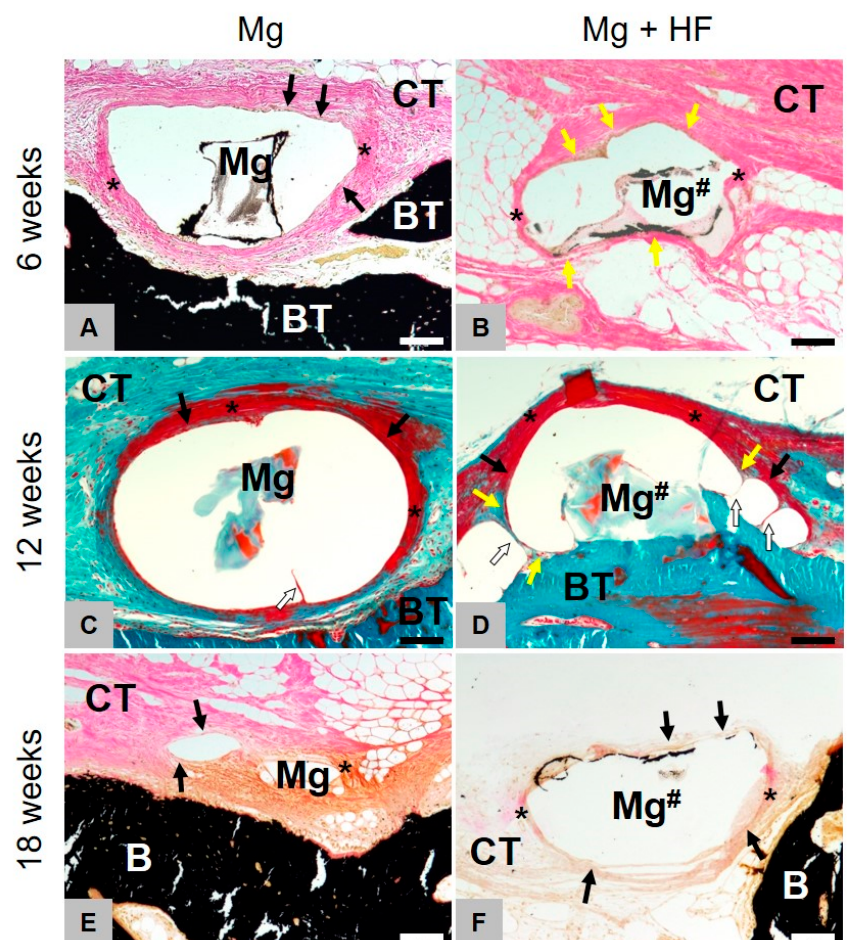
Figure 6. Histopathological comparison of both treated and HF-treated membranes. Images of Masson-Goldner ( C , D ) and Von Kossa ( A , B , E , F ) staining of the implantation site at 6, 12 and 18 weeks (100 × magnifications, scalebars = 100 µm). Left for untreated (Mg) and right for HF-treated (Mg # ) magnesium. Mg is mainly degraded via dissolution and scarcely through phagocytic processes. Mg-HF however, is primarily being resorbed via active phagocytosis and non-cellular dissolution only plays a minor role. After degradation of the HF-coating, decomposition, as with untreated Mg, principally occurs non-cellular-driven but through dissolution. Yellow arrows = phagocytic cells, black arrows = fibroblasts, asterisks = slight fibrosis, white arrows = septa between the gas cavities. Clear di ff erences in the tissue responses to the HF-treated and the untreated magnesium materials were histologically observable (Figure 7). In the case of the untreated magnesium meshes, the mesh bars were surrounded by distinctly pronounced gas cavities. The magnesium bars were only connected to the surrounding connective tissue in small contact areas. Both the material- and the cavity-adherent connective tissue showed signs of a slight fibrosis involving mostly fibroblasts. Within the neighbored connective tissue, only moderate correlates of a material-associated inflammatory response, including mostly fibroblasts and low numbers of macrophages, have been detected at this study time point without signs of a phagocytic